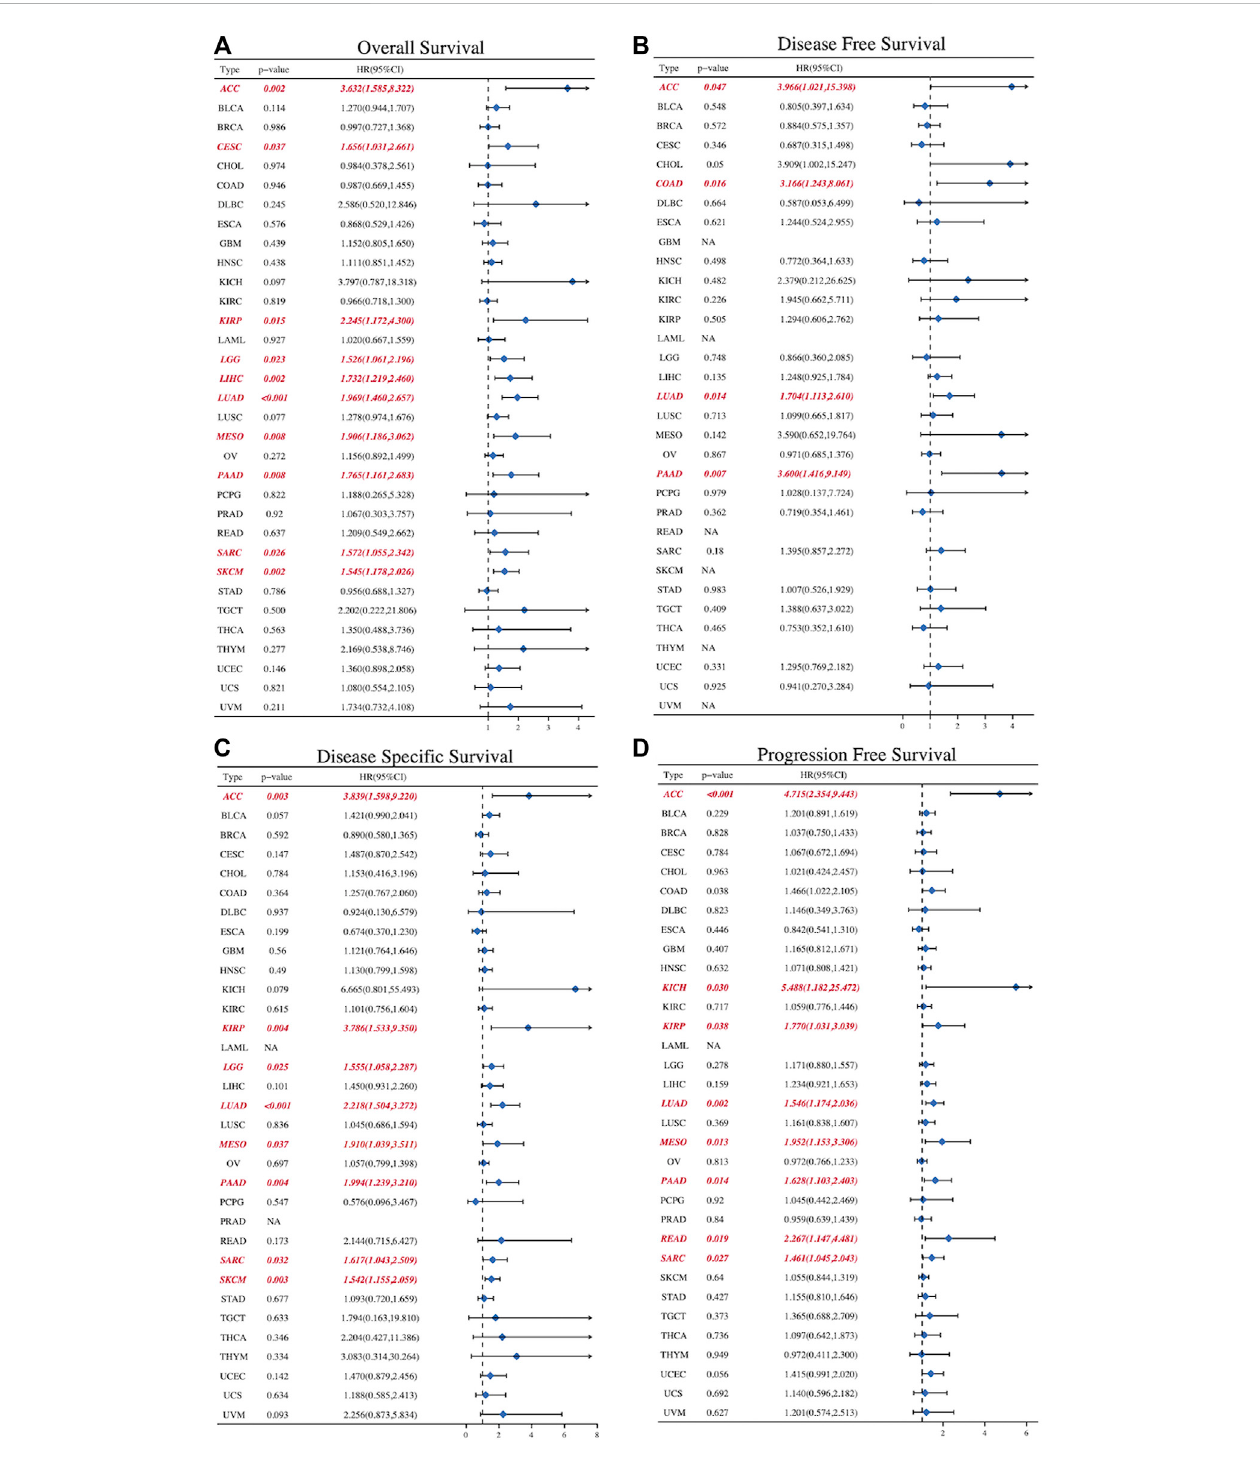
is strongly consistent with the results obtained with UALCAN data.